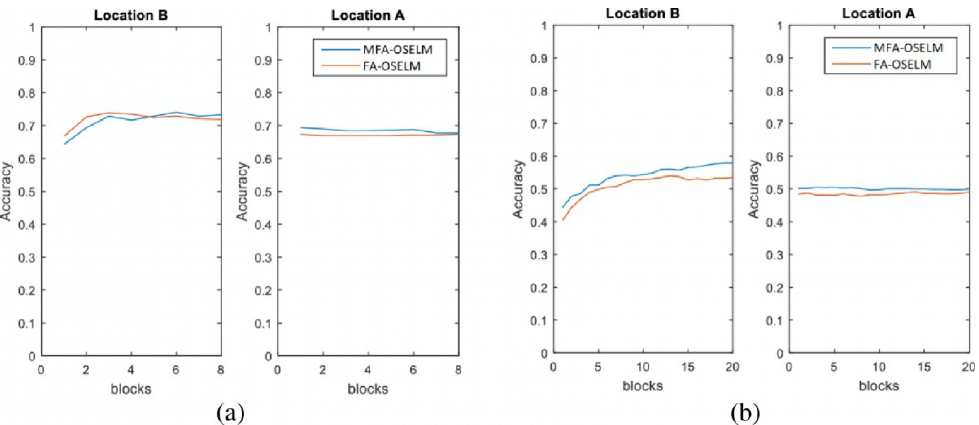
Figure 7. Scenario 3: The accuracy of MFA-OSELM and FA-OSELM for ( a ) the TampereU dataset and ( b ) the UJIIndoorLoc dataset.